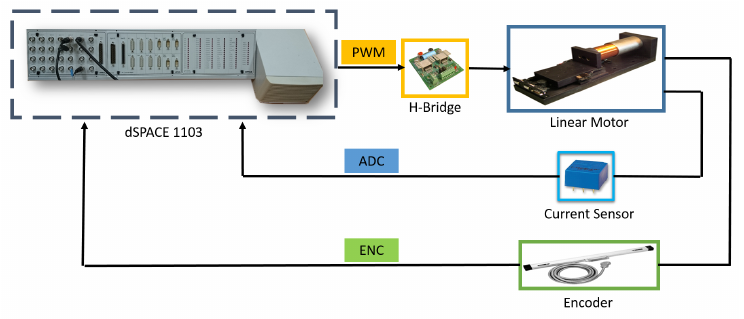
Figure 7. Signals interfaced to the dSPACE 1103 controller board along with their corresponding hardware